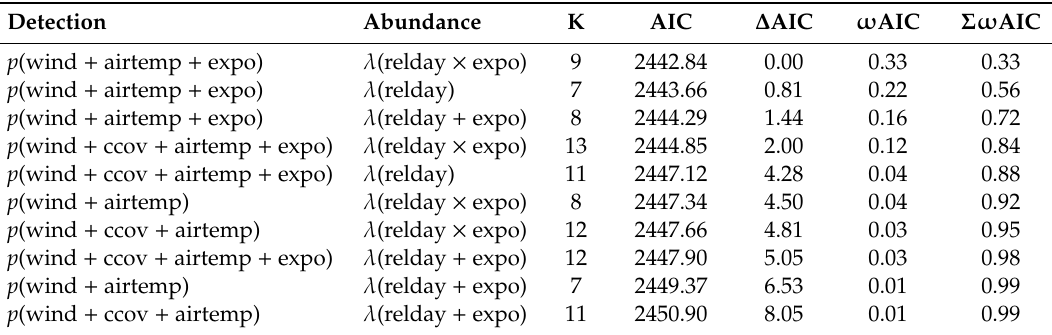
Table 1. Model selection table for the negative binomial parameterization of the N-mixture model. Here we show the subset of 10 models that accounted for all the AIC support ( ω AIC ≥ 0.01). The models are ranked according to their AIC score (lowest is better). The Detection ( p ) and Abundance ( λ ) model formulations are provided, as is the number of parameters in the model (K), the AIC score, the di ff erence in AIC relative to the top model ( ∆ AIC), the AIC weight ( ω AIC) which is a measure of relative model support, and the cumulative AIC weights ( Σ ω